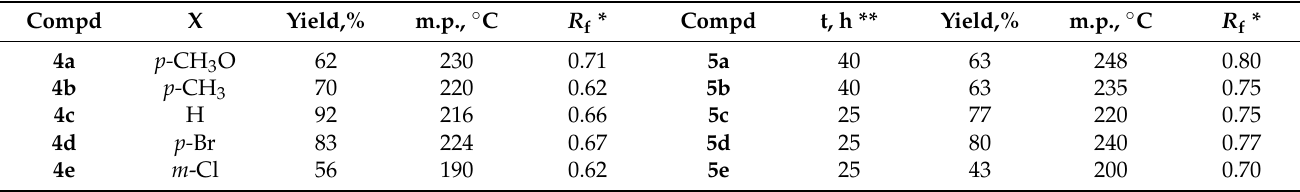
Table 1. Physicochemical data of 5-substituted phenyl-3-[ β -(morpholin-1-yl)ethyl]-1,2,4-oxadiazoles ( 4a – e ) and spiropy- razolinium compounds ( 5a – e ) fixed in the conditions for obtaining single crystals for XRD analysis and in condition ( i